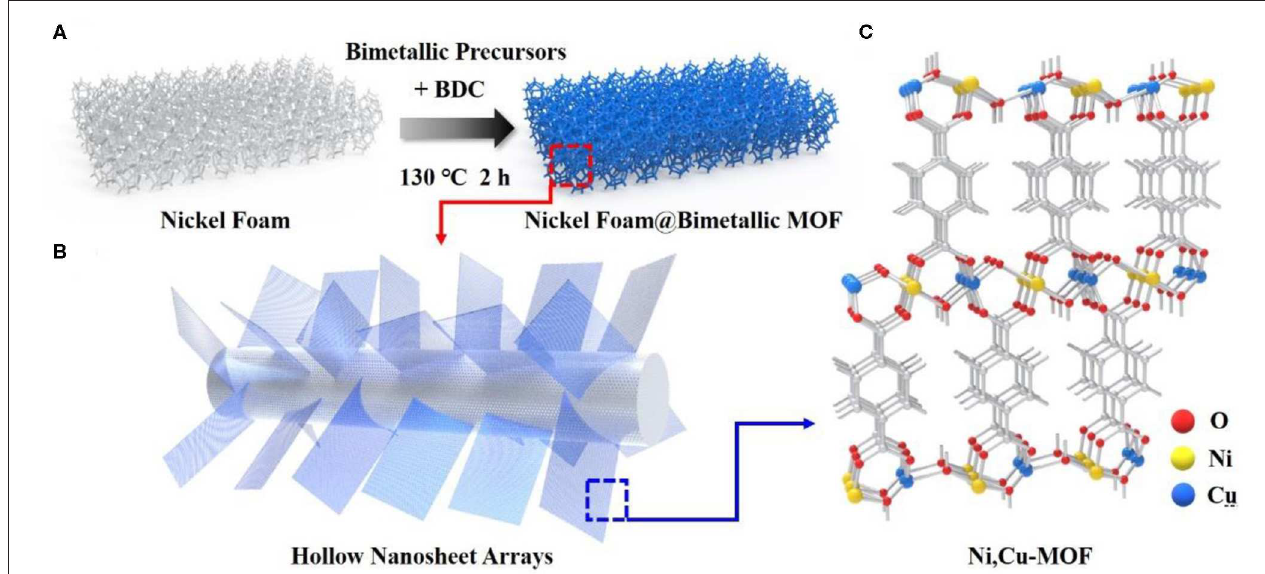
FIGURE 1 | (A) A schematic diagram of growing bimetallic MOFs on pure nickel foam. (B) An enlarged structure diagram of a branch on nickel foam. (C) The schematic diagram of Ni, Cu-MOFs.